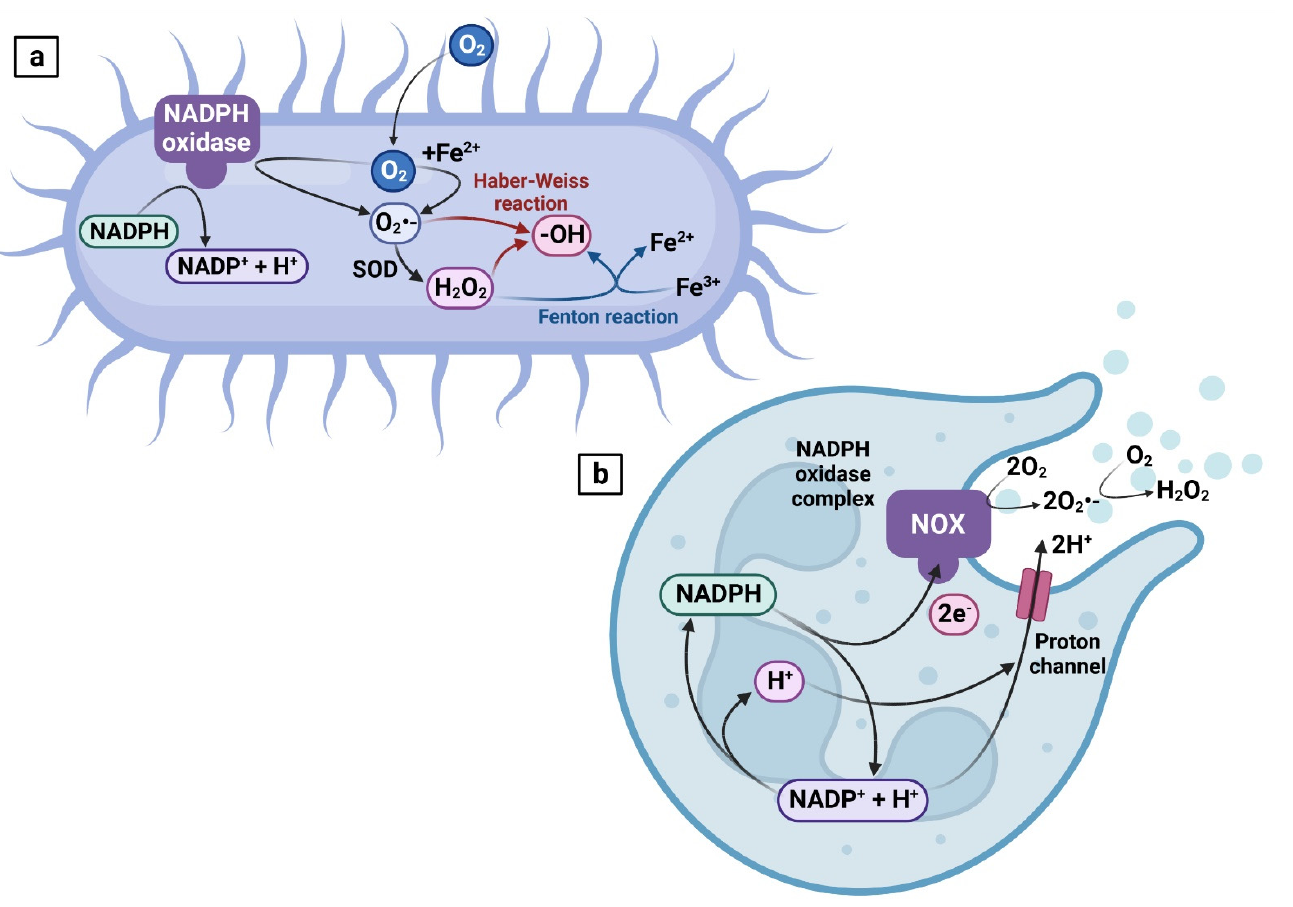
Figure 2. Sources of ROS in aerobic bacteria ( a ) and leukocytes ( b ). While obligate anaerobes are not equipped to perform aerobic respiration, it has been speculated that these can deploy low-potential electron transfer pathways to produce ROS